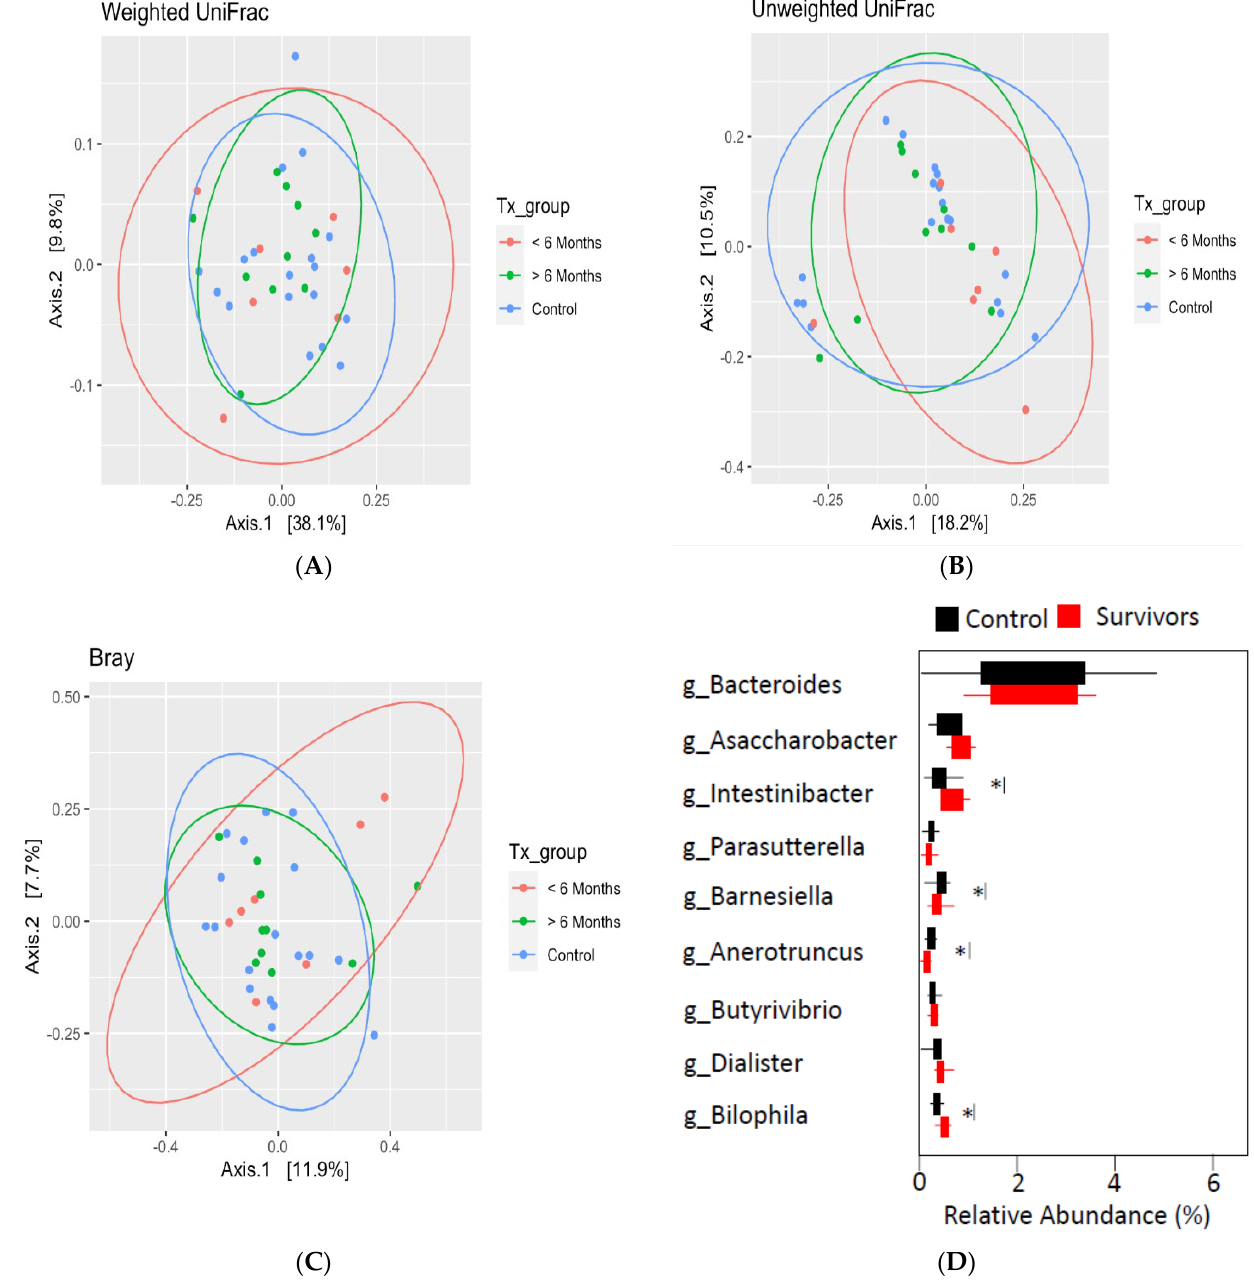
Figure 2. Beta diversity as determined by principal coordinate analysis with weighted ( A ), unweighted ( B ) UniFrac distances, and Bray–Curtis distance ( C ) revealed no significant differences between groups. ( D ) Differential taxonomic abundance analysis at the genus level. Significance is denoted by * at the p < 0.05 level.